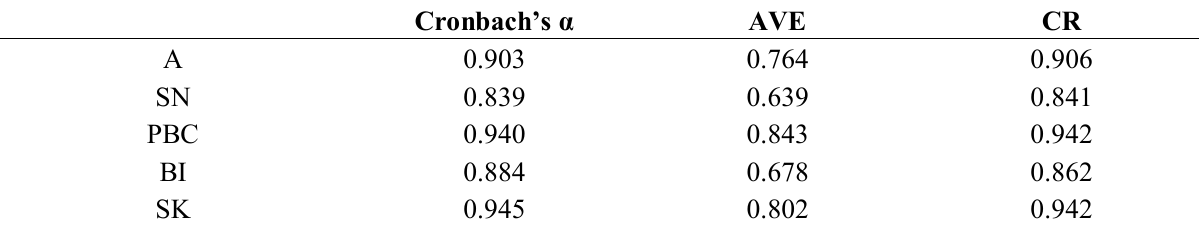
Table 2. Reliability and convergent validity.